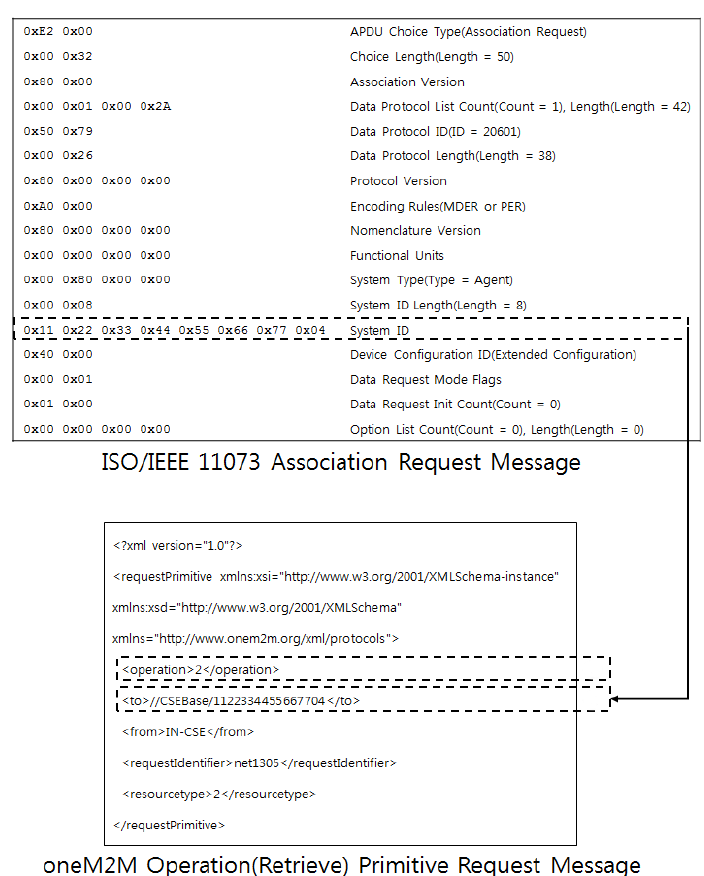
Figure 6. An example of the process described in Figure 5.